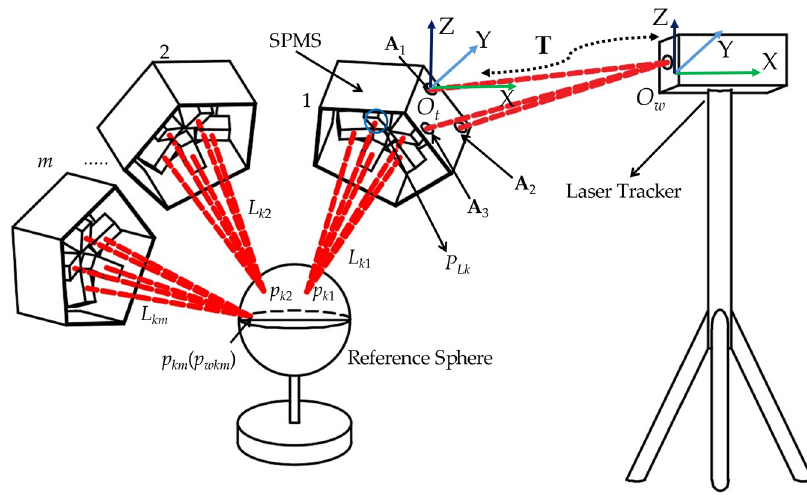
Figure 3. The data acquisition procedure of laser beams based on reference sphere constraint.